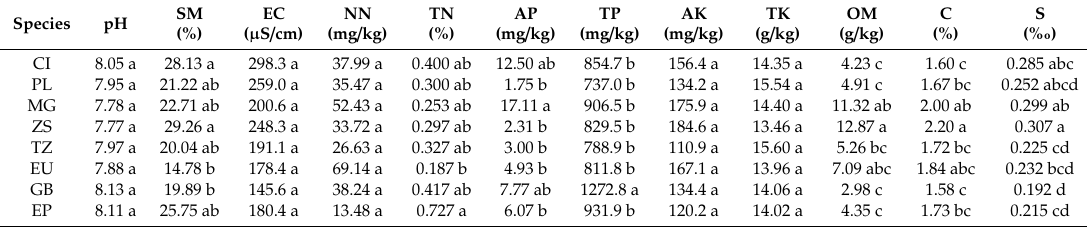
Table 4. Chemical properties of soil in the rhizospheres of eight tree